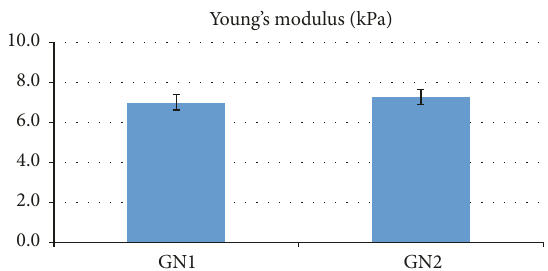
Figure 3: Average value and corresponding standard deviation value of the elastic modulus ( 𝐸 low ) calculated by initial slope of the stress-strain curves obtained by compression tests.